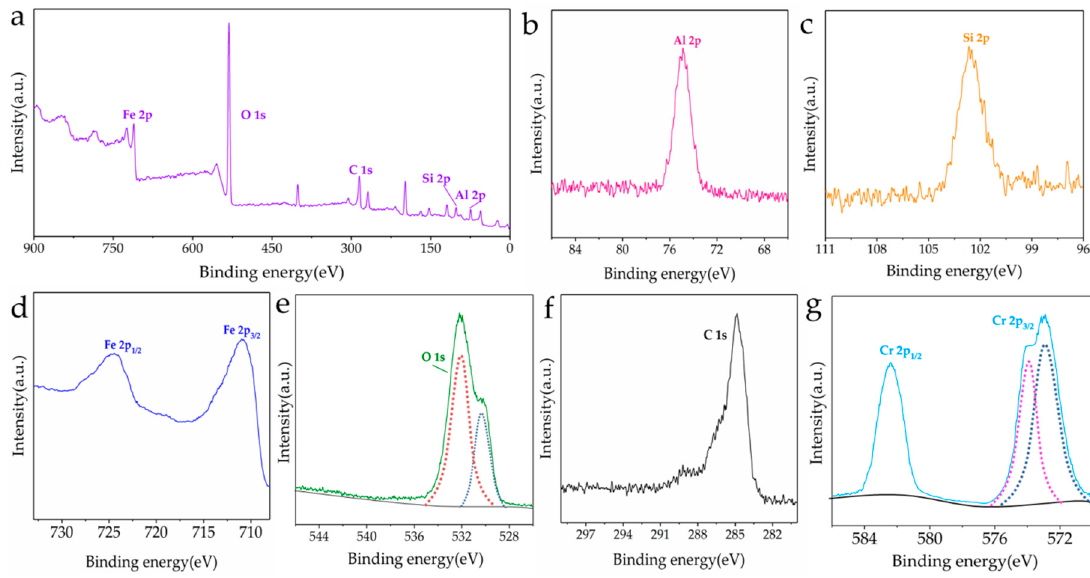
Figure 4. XPS of the MFH nanocomposites before ( a – f ) and after ( g ) removal experiments.